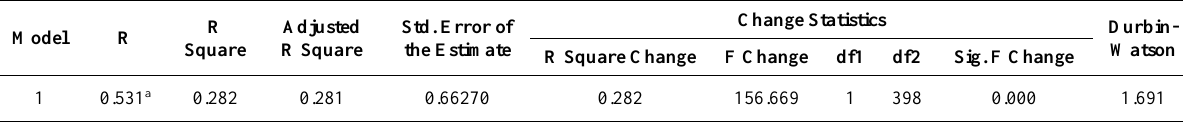
Table 5. Model Summary b for digitalization and quality of service